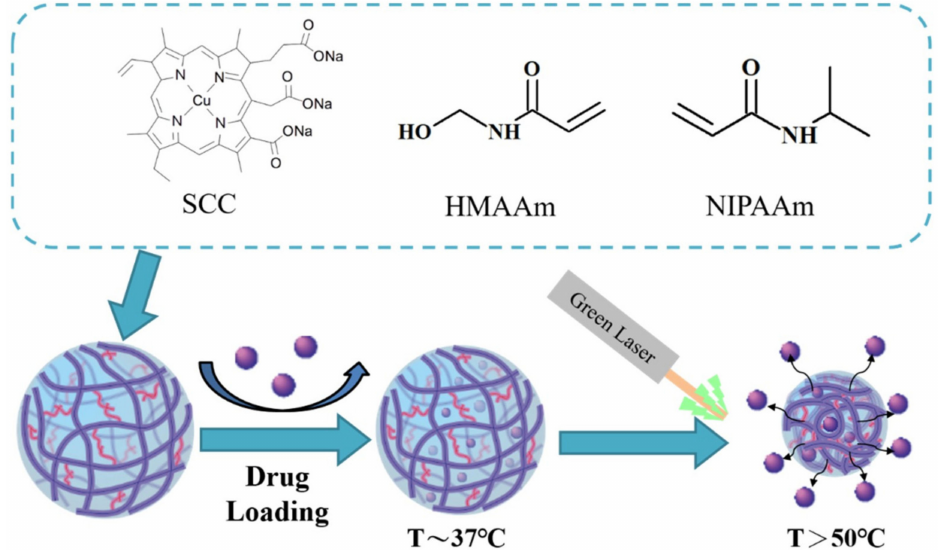
Figure 35. Green laser light induced nanogels (reproduced from [156] with permission from Polymers , MDPI licensed under Creative Commons Attribution (CC BY 4.0) license).